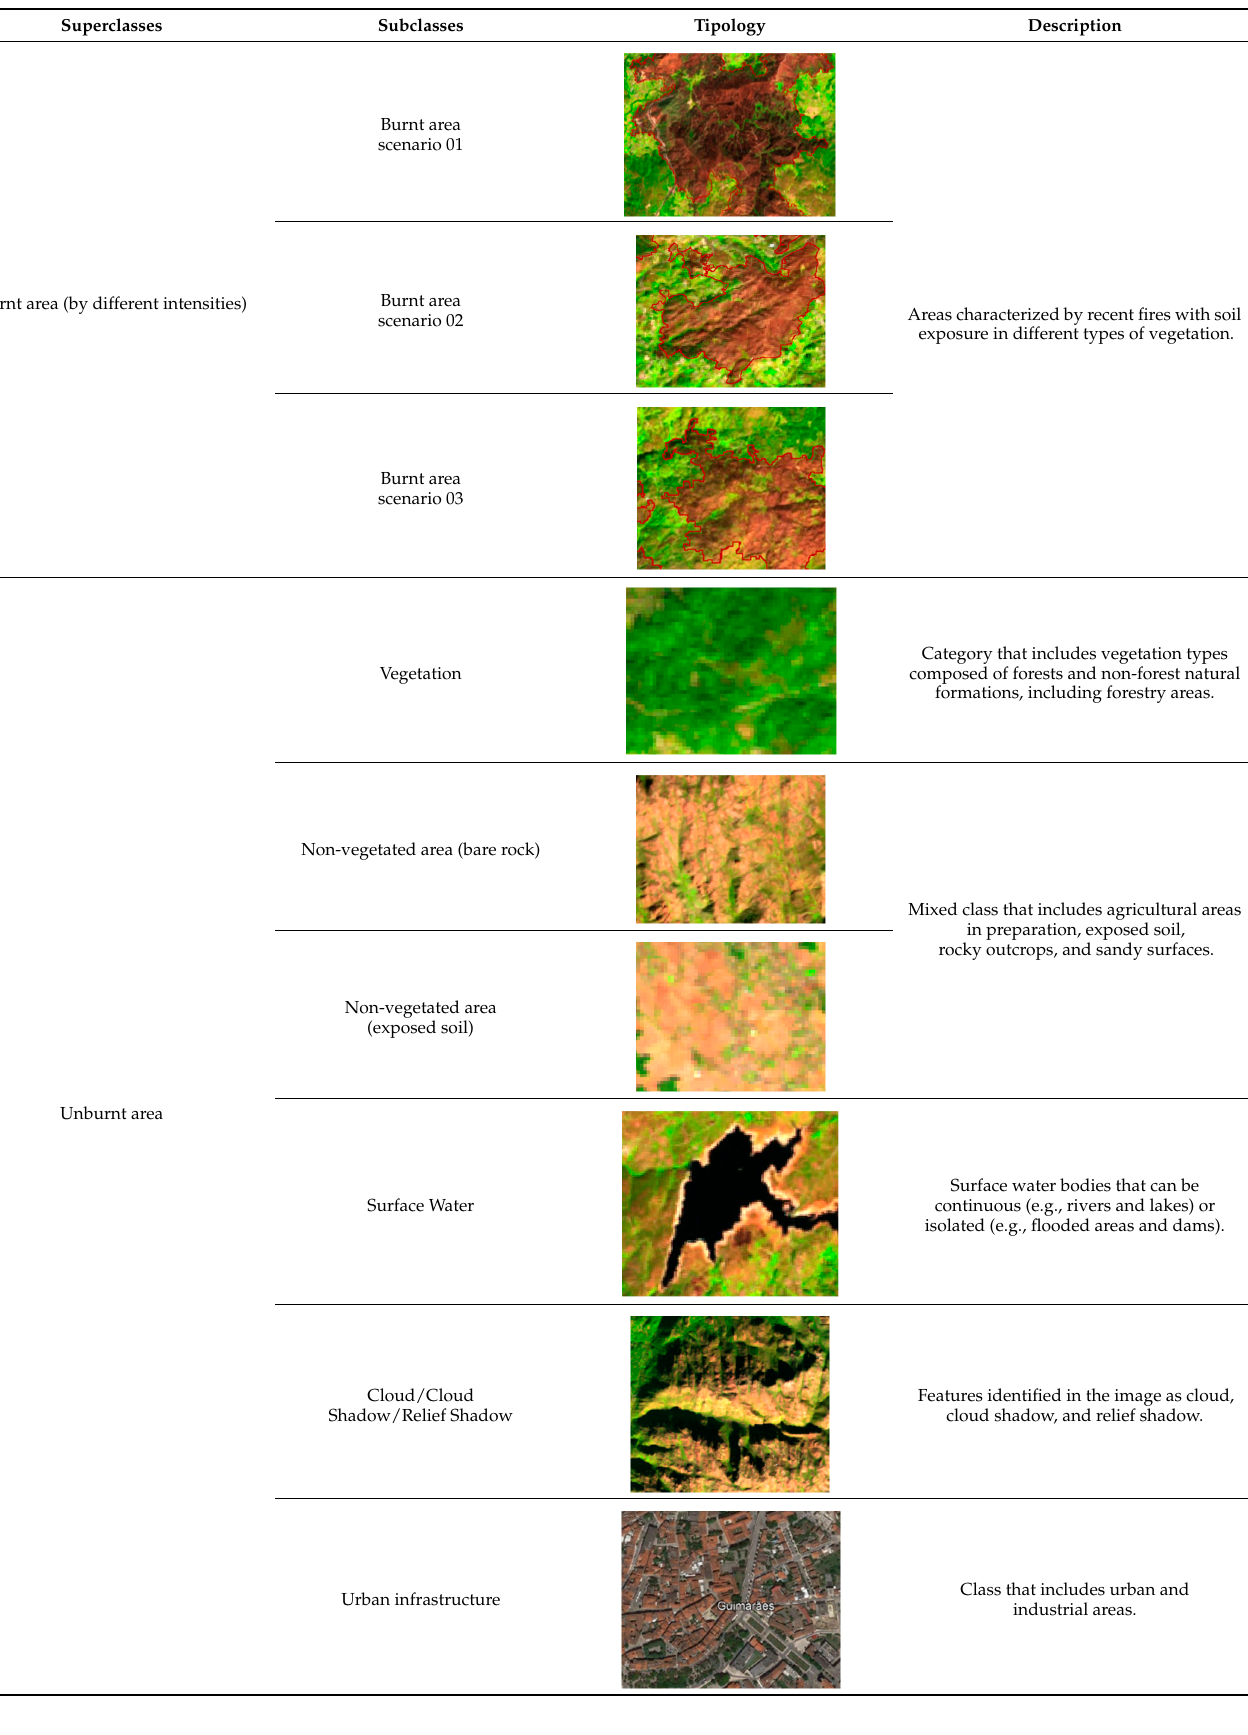
Table 1. Definition of the typologies of classes present in the images.